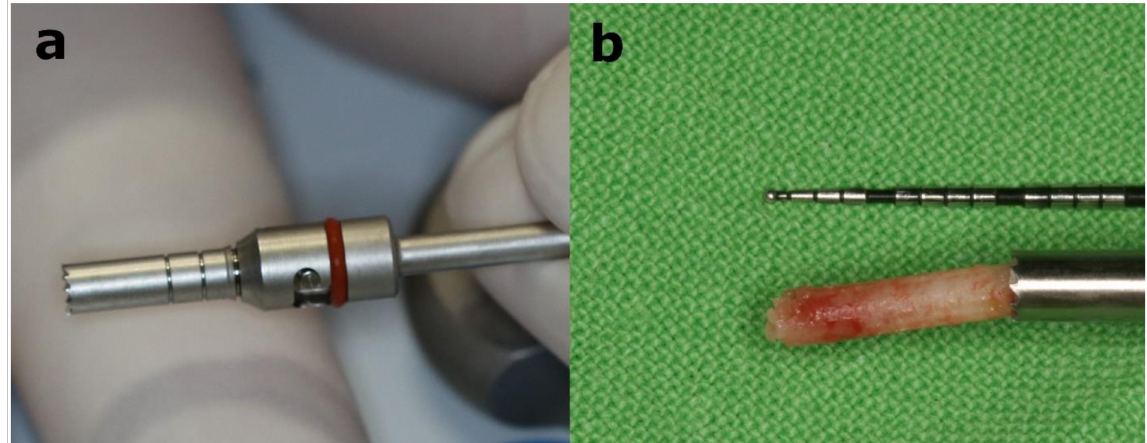
Figure 2. A 10 mm working length modular trephine drill with 2 mm internal and 2.7 mm outer diameter ( a ) was used as initial drill for implant placement to collect bone core biopsy samples for histological, histomorphological and micromorphological analysis ( b